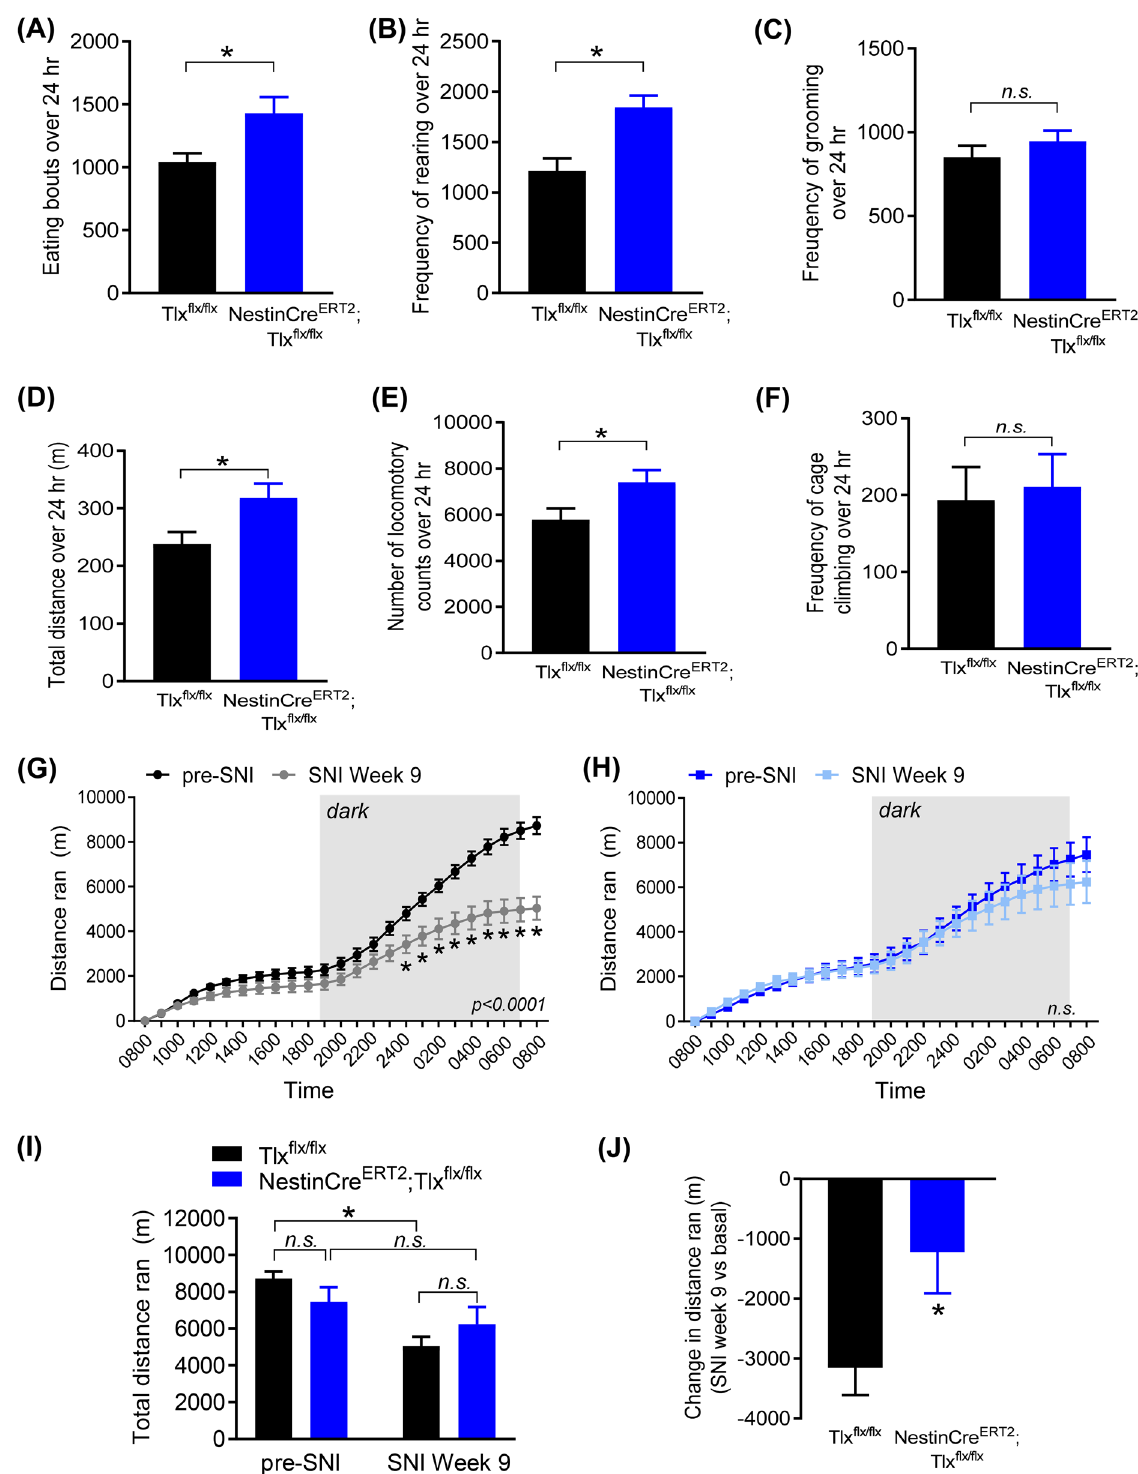
Figure 5. Assessment of spontaneous and voluntary behaviors. ( A–F ) LABORAS home cage behavioural recording over 24 h of eating bouts ( A ), rearing ( B ) and grooming ( C ) frequencies as well as total movement ( D ), locomotory counts ( E ) and frequency of cage climbing ( F ) 8 weeks after SNI operation in control TIx flx/flx and NestinCre ERT2 ; TIx flx/flx mice. ( G,F ) Comparison of the 24 h voluntary wheel running distances pre- and post-SNI in the control TIx flx/flx ( G ) and NestinCre ERT2 ;TIx flx/flx mice ( H ). ( I ) Comparison of the total distance ran over 24 h in the wheel and ( J ) comparison of the change in total distance ran in the wheel 9 weeks post-SNI versus the respective pre-injury values in individual animal. * p < 0.05, unpaired t-test ( A–F,J ), two-way ANOVA with repeated measures ( G–I ); n.s. not